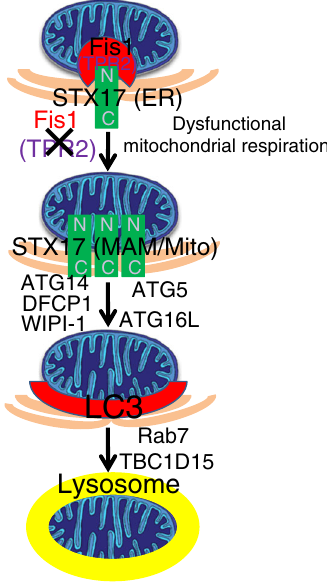
Fig. 9 Model. Hypothetical model of syntaxin 17 (STX17)-induced mitophagy upon mitochondrial fi ssion 1 protein knockout ( Fis1 KO